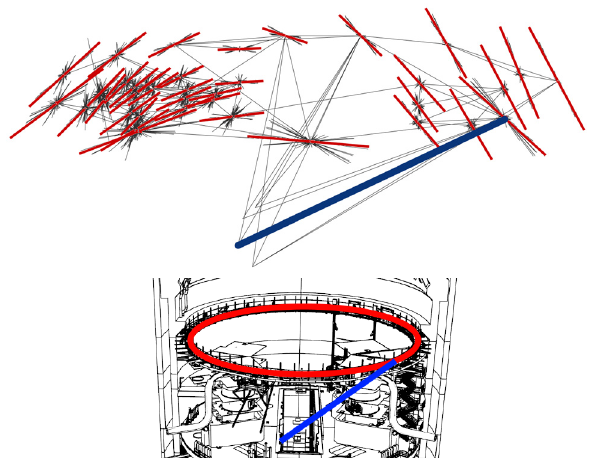
Figure 5: top : rakes of reliability of a 3D network; bottom : location of the 3D network: at the top of the building, only accessible through ladders. The blue line is the sight of a referencing target; all red lines are the influence of the gross error threshold on this specific observation; this kind of interaction is helpful in the stage of outlier detection and dataset documentation.